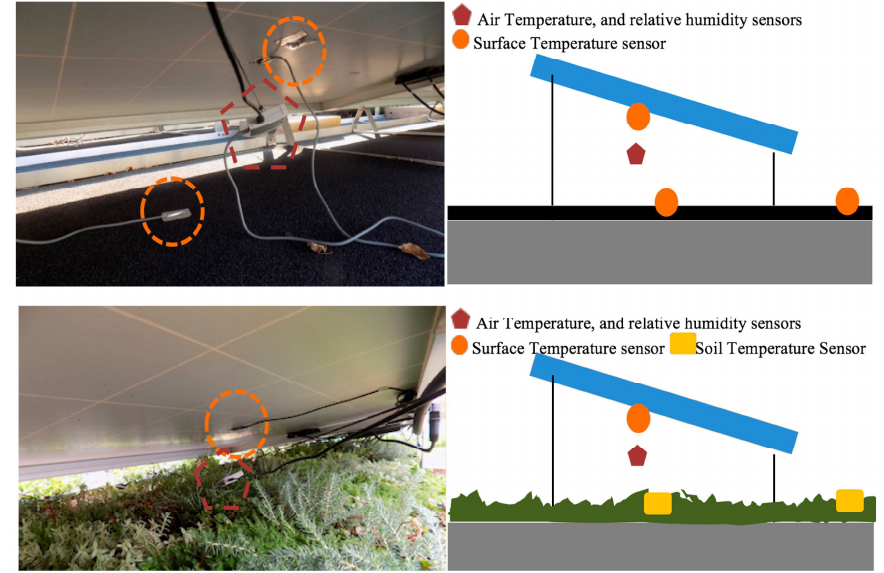
Figure 3. Sensor locations ( left ) and schematic of sensor types and locations ( right ).